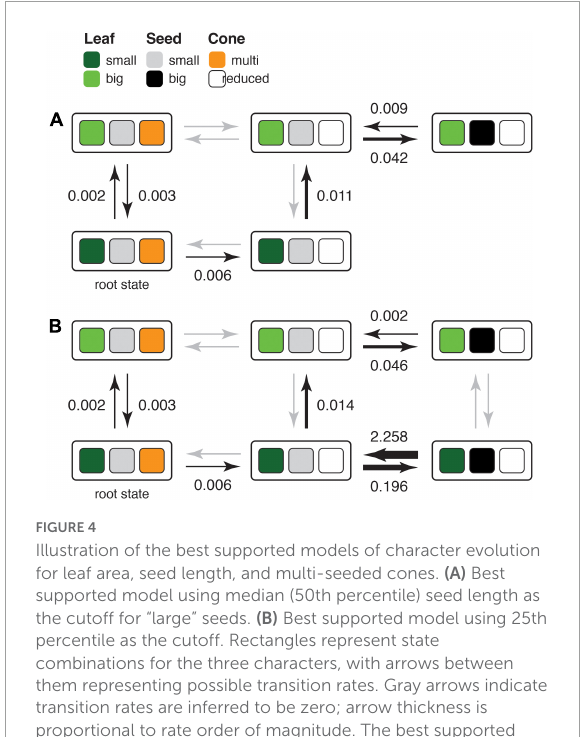
FIGURE4 Illustration of the best supported models of character evolution for leaf area, seed length, and multi-seeded cones. (A) Best supported model using median (50th percentile) seed length as the cutoff for “large” seeds. (B) Best supported model using 25th percentile as the cutoff. Rectangles represent state combinations for the three characters, with arrows between them representing possible transition rates. Gray arrows indicate transition rates are inferred to be zero; arrow thickness is proportional to rate order of magnitude. The best supported models (see Table 1 ) had a fixed root state with small leaves, small seeds, and multi-seeded cones.